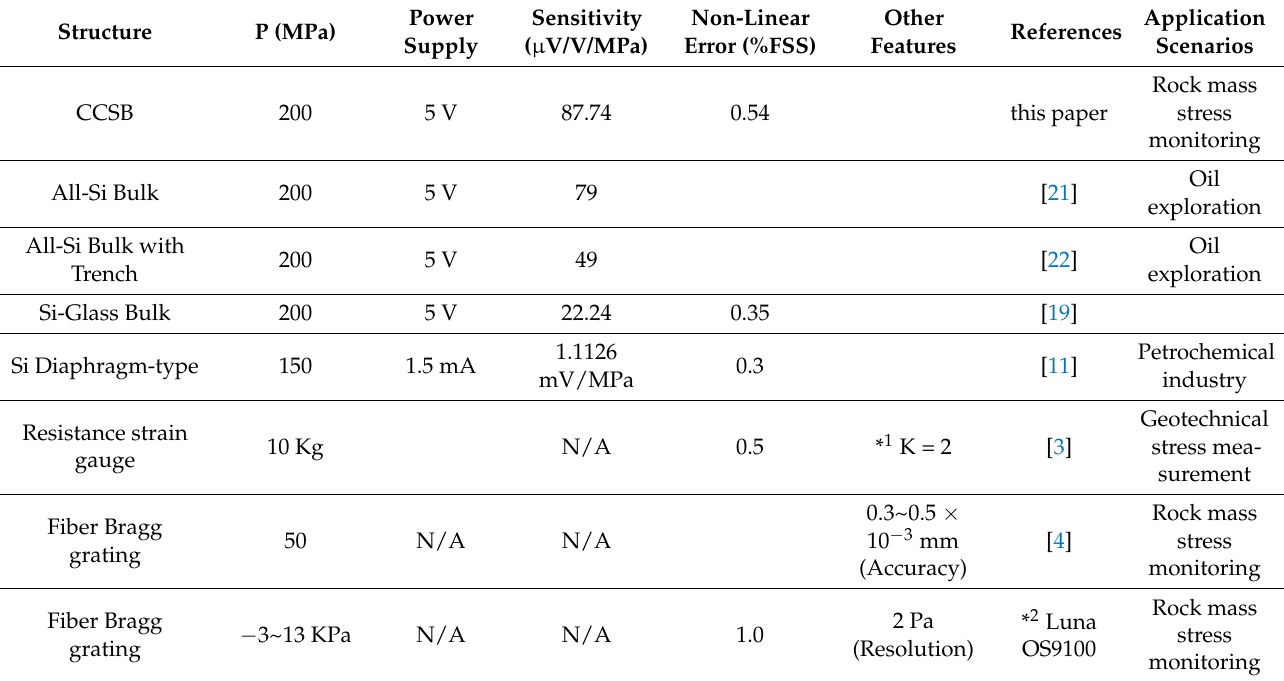
Table 5. Performance comparison of pressure